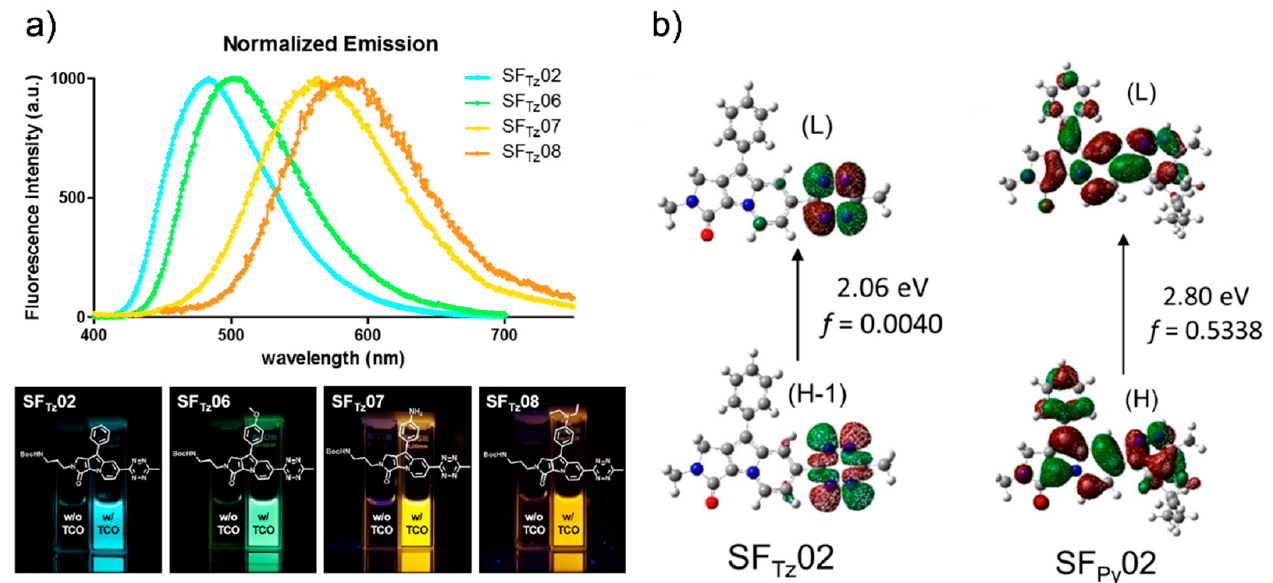
Figure 6. Development of a monochromophore-based, tetrazine-functionalized fluorophore. ( a ) Upper panel: Normalized emission spectrum of SF Tz (SF = Seoul-Fluor) probes after reaction with TCO. Lower panel: Photograph of the SF Tz probes before (left cuvette) and after (right cuvette) reaction with TCO; irradiated under 365-nm UV light. ( b ) Molecular orbital distribution, vertical transition energy, and oscillator strength ( f ) of SF Tz 02 (left) and the corresponding iEDDA reaction product (right) obtained by Time-Dependent-DFT calculations (CAM-B3LYP/6-31G*) of the corresponding first excited-state optimized structures. Reproduced with permission from [29]. Copyright (2018) American Chemical Society.